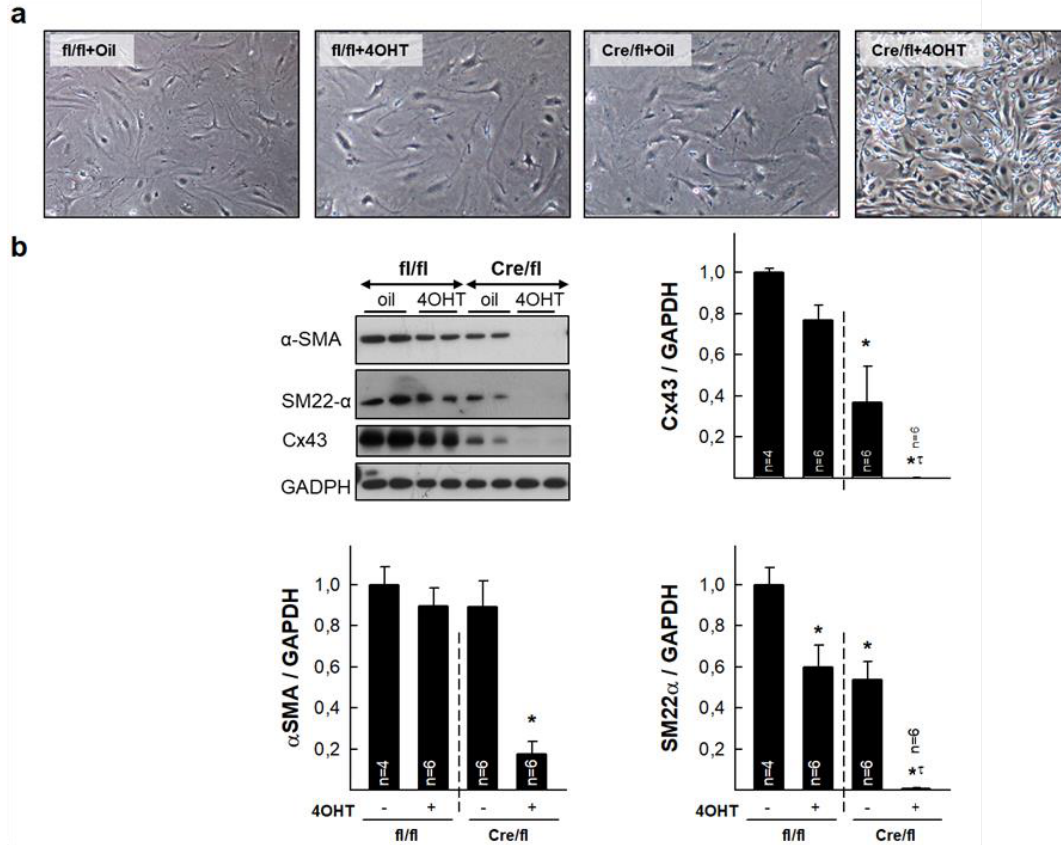
Figure 6. Altered phenotype and expression of differentiation markers in isolated cardiac fibroblasts from Cx43 fl / fl and Cx43 Cre-ER(T) / fl mice. ( a ) Upper images show morphology of cardiac fibroblasts isolated from control hearts from the four groups of animals. ( b ) Representative Western blots for Cx43, α SMA and SM22 α , and total protein expression of analyzed proteins, in fibroblasts isolated from hearts from Cx43 fl / fl (fl / fl) and Cx43 Cre-ER(T) / fl (Cre / fl) mice. * ( p < 0.05) indicates significant di ff erences vs. Cx43 fl / fl + oil animals. τ ( p < 0.05) indicates significant di ff erences vs. Cx43 Cre / fl + oil animals.